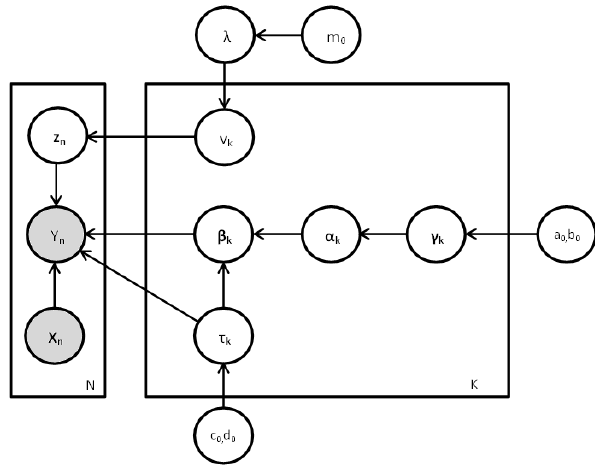
Figure 1. Graphical representation of the complete Bayesian hier- archical